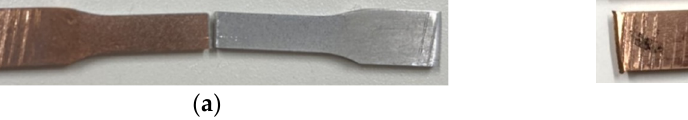
Figure 17. Fractured tensile test specimen joined using shaved surface: ( a ) Fracture at joint boundary; ( b ) Fracture at C1100 part.